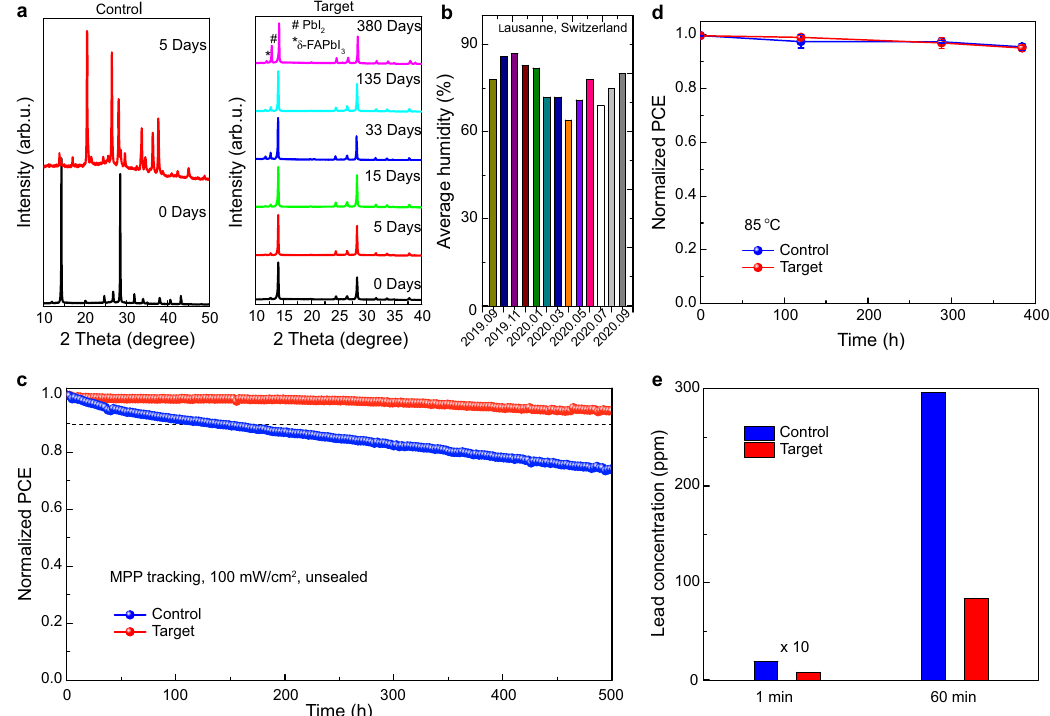
Fig. 5 Stability and enviromental impact. a Ambient stability of the control perovskite fi lm (left) and target perovskite fi lm (right) based on the evolution of the XRD patterns of the perovskite fi lms stored in an ambient environment for various times. b The average relative humidity during the aging process in Lausanne, Switzerland. c Maximum power point tracking measured with the unencapsulated device under full solar illumination (AM 1.5 G, 100 mW cm − 2 in N 2 , 25 °C). d Thermal stability of perovskite devices at an elevated temperature of 85 °C. e Assessment of lead leakage upon immersing solar cells into water. The PCE refers to the steady-state ef fi ciency. The concentration of lead in water was determined by inductively coupled plasma optical emission spectroscopy (ICP-OES)